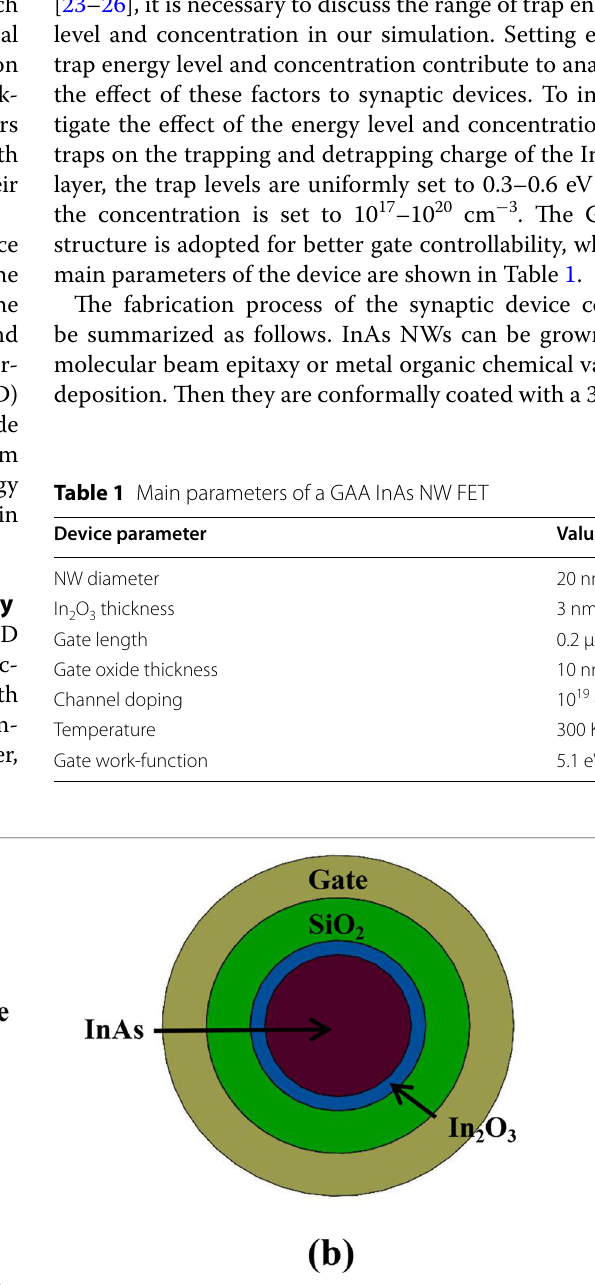
Fig. 1 a Schematic diagram of a GAA InAs NW FET. b Cross section diagram